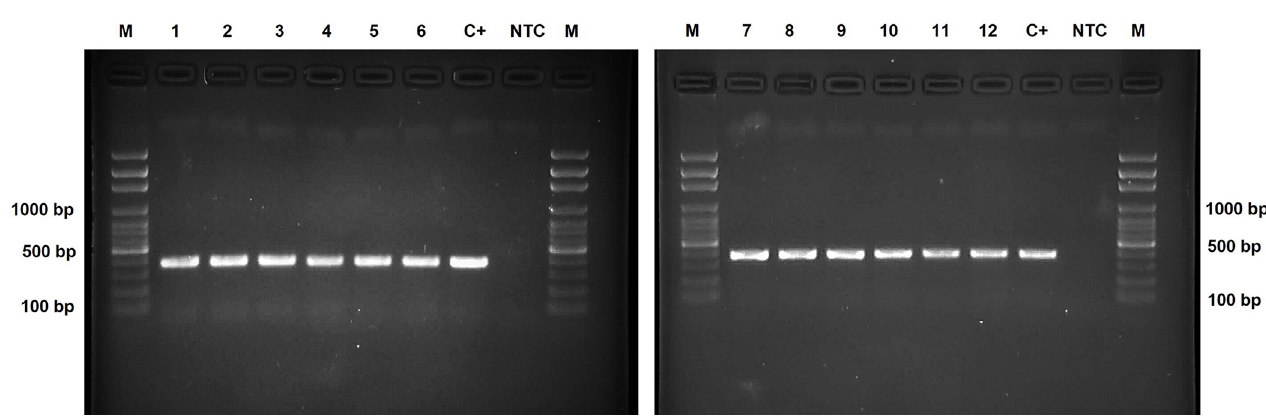
Fig 2. Electrophoresis of cox 1 gene (378 bp) amplified fragments using nested PCR in paraffin tissue samples of patients with appendicitis due to E . vermicularis in Tehran and Hamedan provinces. M:100 bp DNA Marker (Gene Ruler ™ , Fermentas); lane numbers 1–12: amplicons related to FFPE tissues; C +: positive control (the adult worm); NTC: no template control negative control.